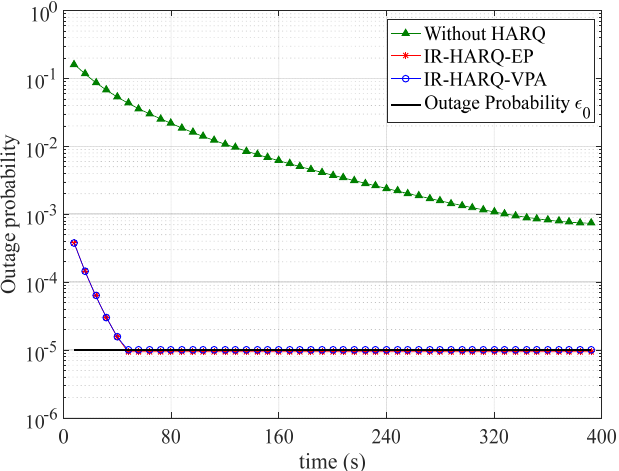
Figure 13. The outage probability of different transmission schemes for half of the communication window.